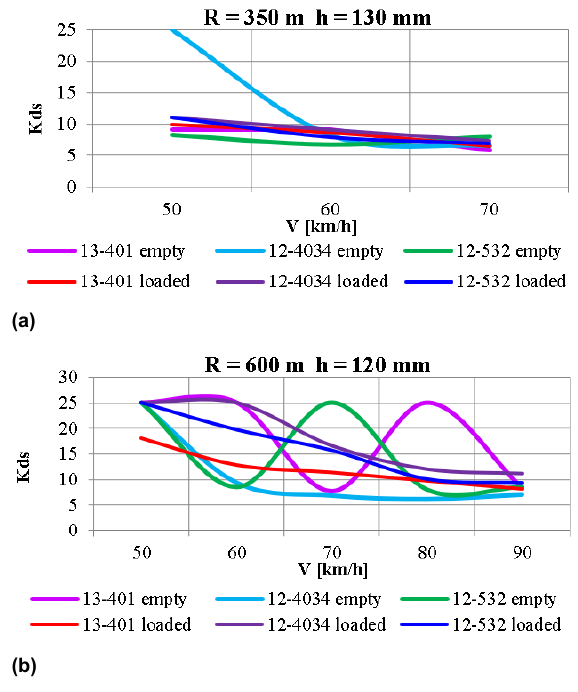
Figure 12. Variation of the safety factors of the wheel against derailment with the motion speed: (a) R=350 m curve; (b) R=600 m